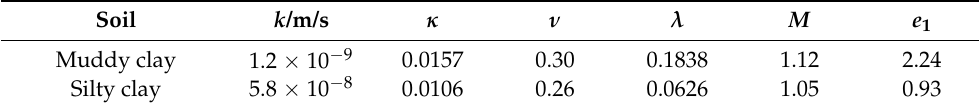
Table 2. Parameters of the modified Cam–Clay